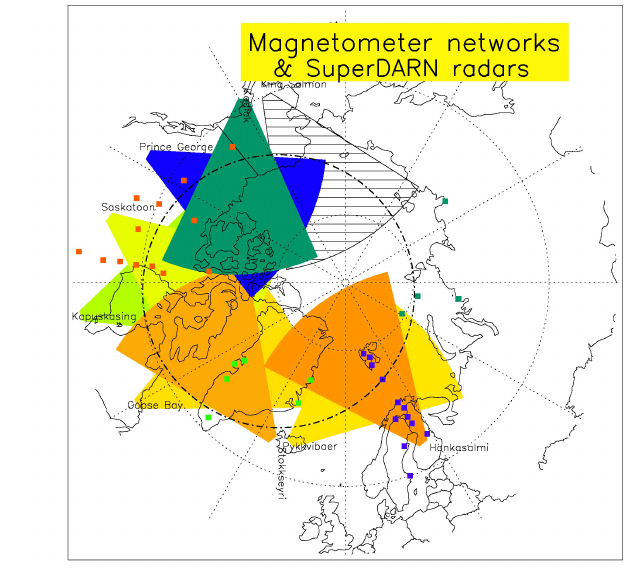
Fig. 5. Northern hemisphere map illustrating the coverage of Su- perDARN and magnetometer networks used in this study (see text for details). The shaded area is the field-of-view of a radar under